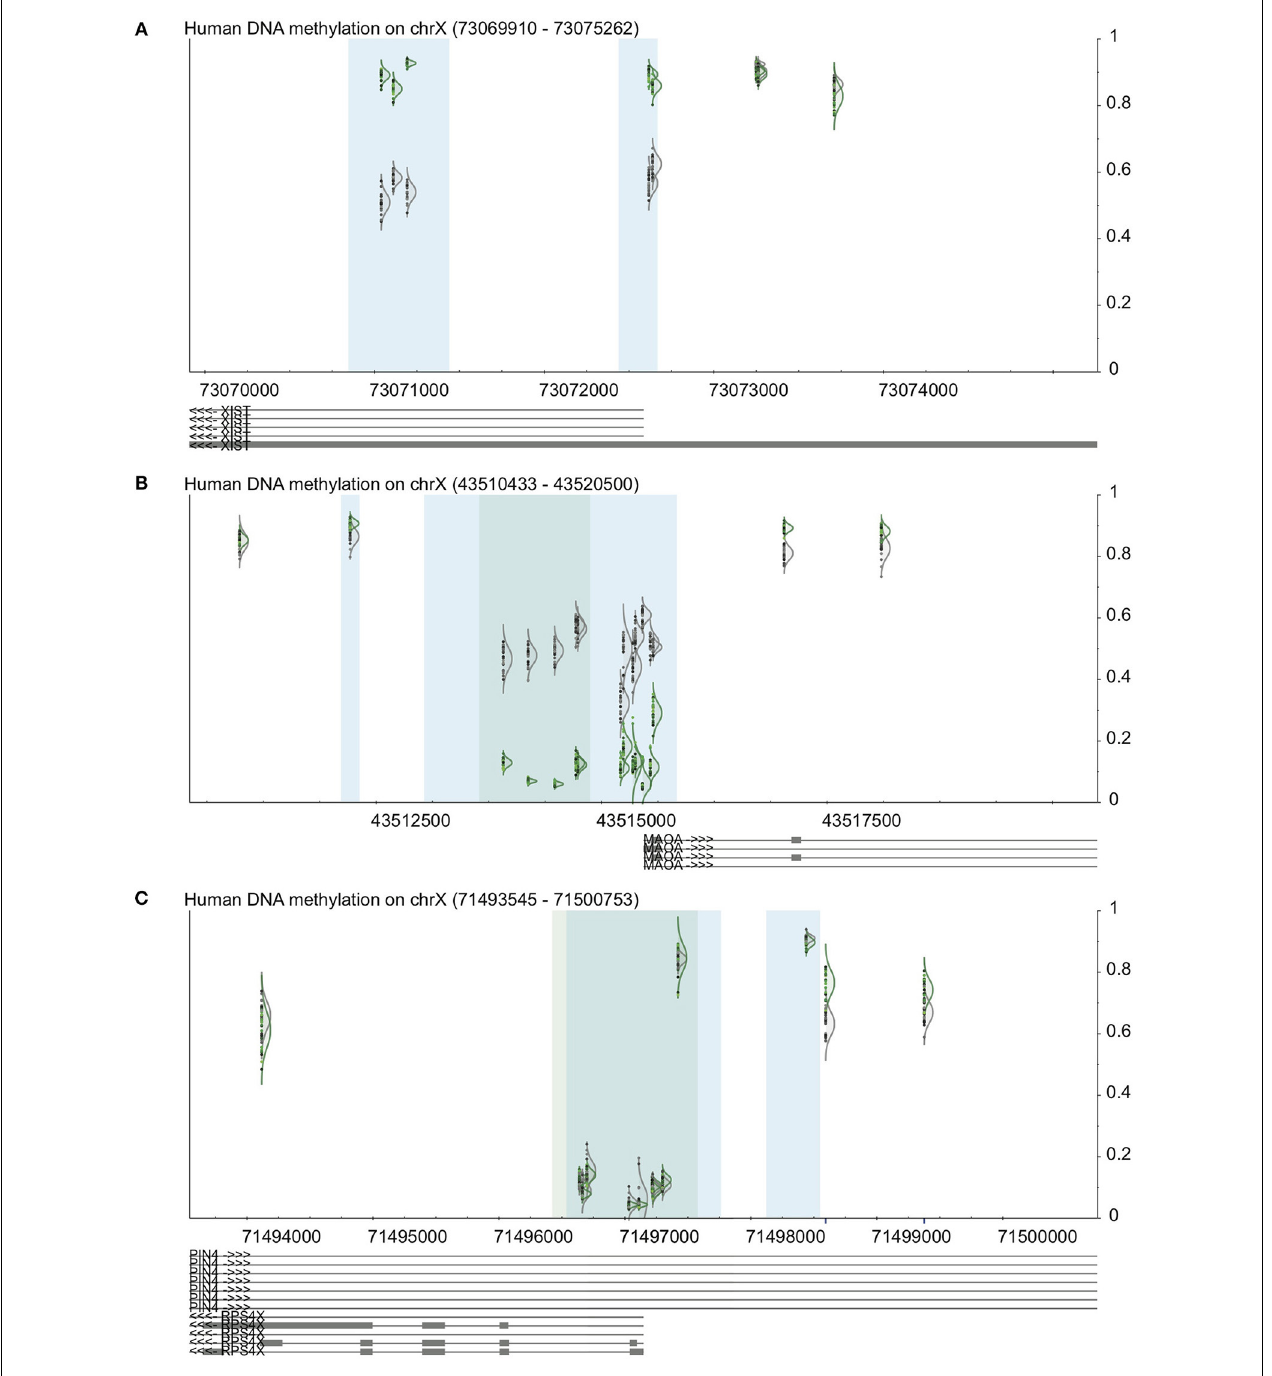
FIGURE 3 | Validation of visualization methods using examples from the X chromosome. See Figure 1 for key. In all panels, female samples are in gray and male samples in green. (A) XIST promoter shows high methylation in